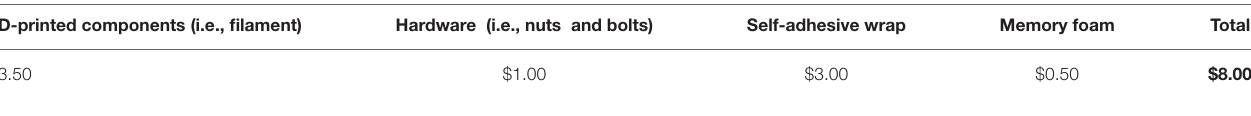
TABLE 2 | Cost analysis (listed in